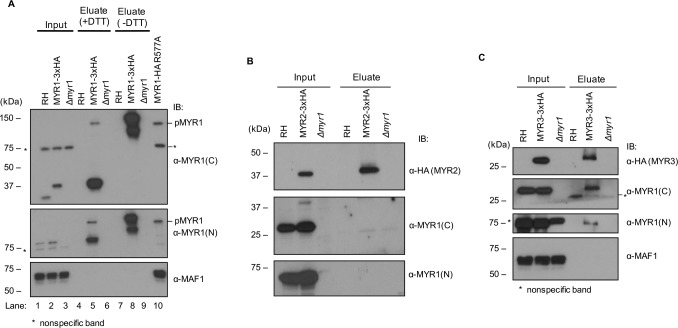
Identification of a MYR1/3 complex.(A) Immunoprecipitations were performed using anti-HA magnetic beads incubated with whole lysate from HFFs infected 24 h with the untagged RH strain (lanes 1,4,7), RH:MYR1-3xHA strain (lanes 2,5,8), or RHΔmyr1 strain (lanes 3,6,9). The input contained ~1% of the amount of starting material relative to the eluate lanes. For lanes 7–9, dithiothreitol (DTT) was omitted from the sample buffer to assess disulfide-mediated interactions. Lysate from RH:MYR1-HA R577A strain was included as a control (lane 10). Immunoblotting (IB:) was performed with antibodies raised to MYR1(C), MYR1(N) or MAF1 (as a negative control). Size markers in kDa are shown to the left. The asterisk indicates a nonspecific, cross-reacting band that is present even in the Δmyr1 line, as previously described using these antibodies [27]. pMYR1 indicates the uncleaved precursor MYR1, as previously described [27]. (B) Immunoprecipitations were performed as described in (A) except using RH:MYR2-3xHA62 tachyzoites and anti-HA antibodies to detect the HA-tagged MYR2. (C) Immunoprecipitations were performed as in (A) except using RH:MYR3-3xHA tachyzoites and anti-HA antibodies to detect the HA-tagged MYR3.